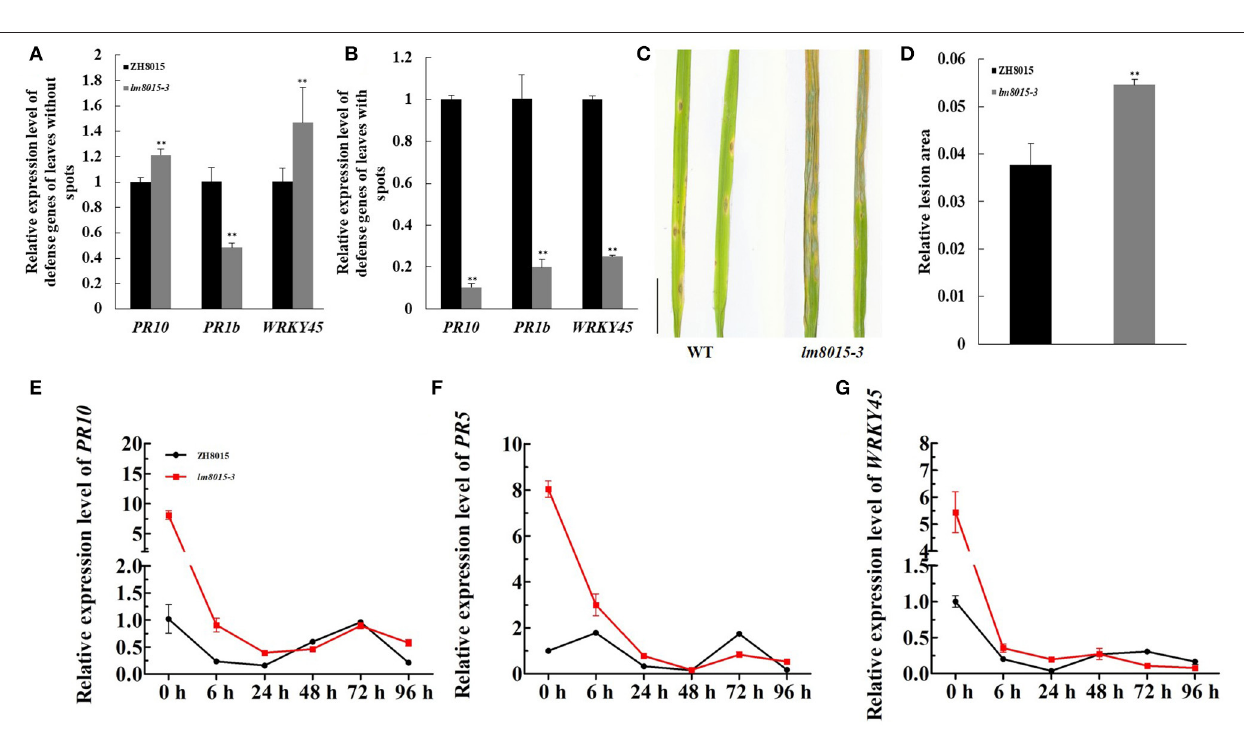
FIGURE 5 | M . oryzae resistance of ZH8015 and lm8015-3. (A,B) Relative expression analysis of defense genes of the leaves with and without spots. The leaves without spots were younger leaves of lm8015-3 with no lesions at the tillering stage, whereas the leaves with spots were older leaves of lm8015-3 with lesions at the tillering stage. (C,D) Spray inoculation and statistics of relative lesion area of the 3-week-old wild type (ZH8015) and lm8015-3 . (E–G) Analysis of relative expression levels of PR10 , PR5 , and WRKY45 of the 3-week-old ZH8015 and lm8015-3 after inoculation. **Significant at P < 0.01 ( t -test); Error bars represent SD ( n = 3). resistance, whereas sl-MH did not (Tian et al., 2020). We speculate that there are two main reasons for this